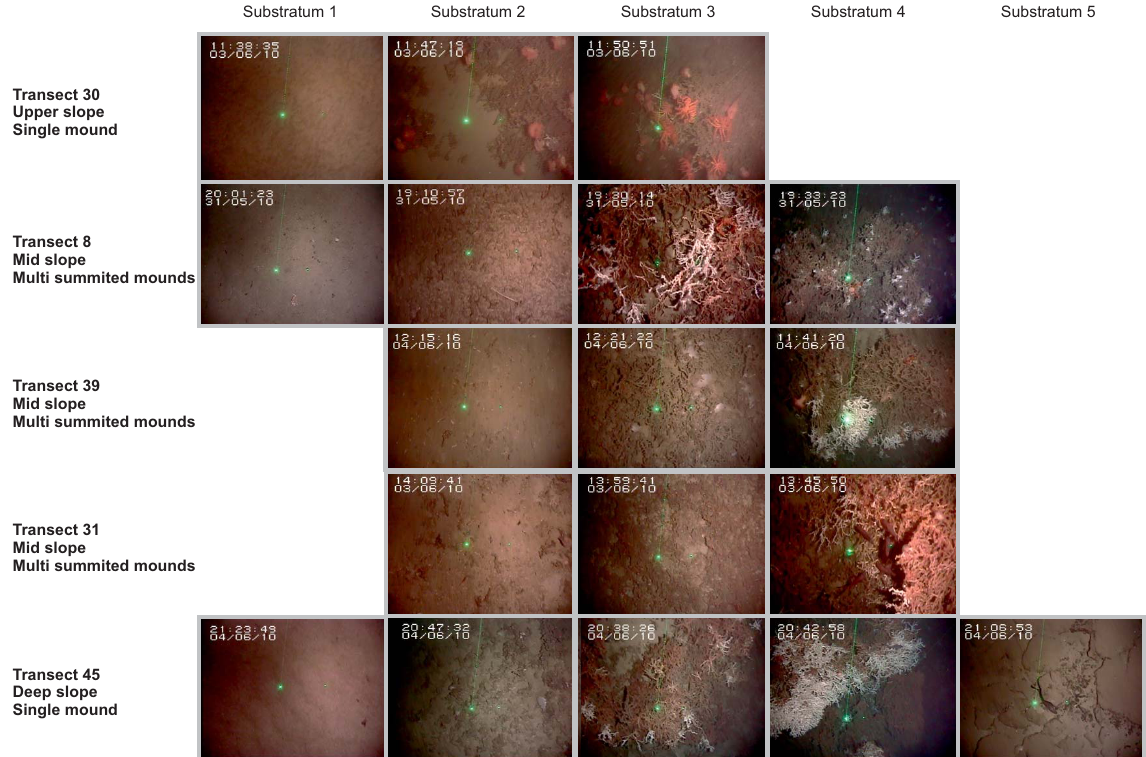
Fig. 6. Still images taken from the video transects characterising different substratum types. For explanation of the substrata numbers see Fig.